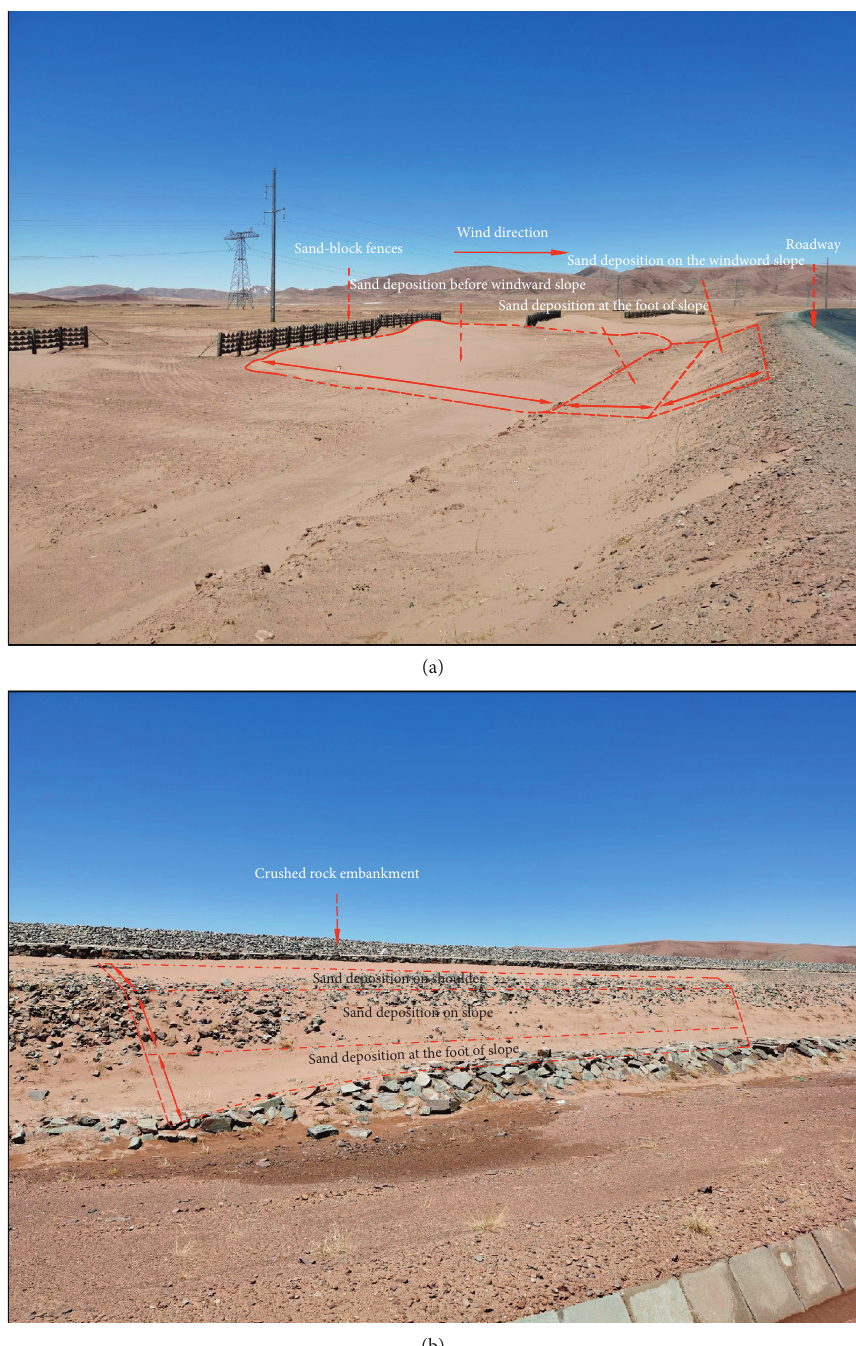
Figure 1: Wind-blown sand deposition around the embankments of the Qinghai-Tibet Roadway (a) and Qinghai-Tibet Railway